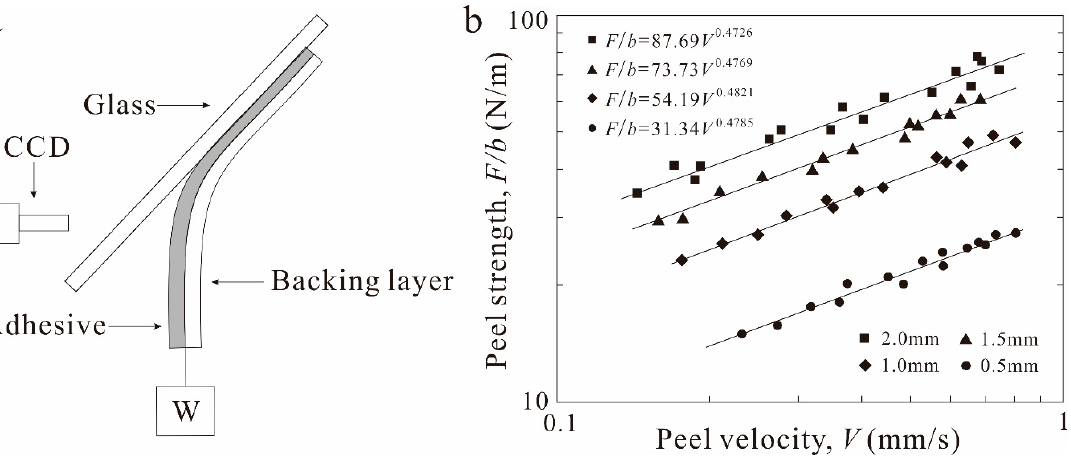
Figure 4. Results of the peeling test. ( a ) Schematic diagram of the peeling experiment; ( b ) The relationship between peel strength and peel velocity at a peeling angle of 30° with different thicknesses of backing layer in log-log coordinates.